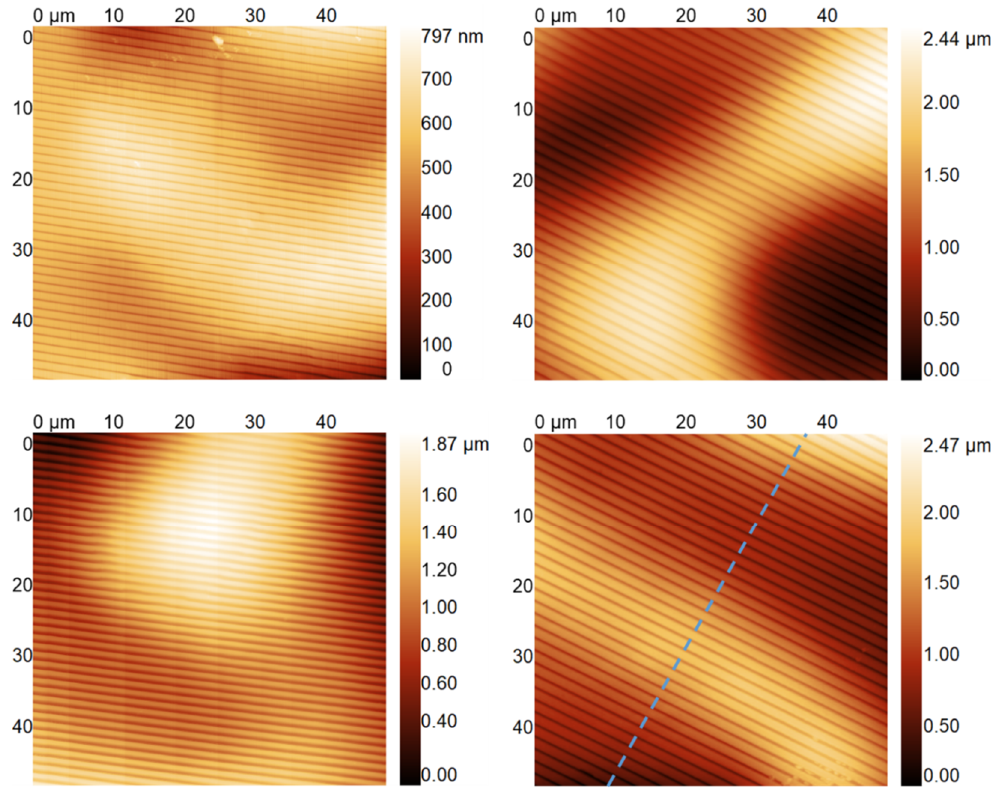
Figure 9. AFM image of the final imprint. The left and right images have line and space dimensions of 300 nm/900 nm and 400 nm/1200 nm, respectively. Comparing these with the results from Figure 5, it can be seen that the hierarchical structures could be replicated with high fidelity. The dashed line in the lower right corner indicates the location of the linescan shown in Figure 10.